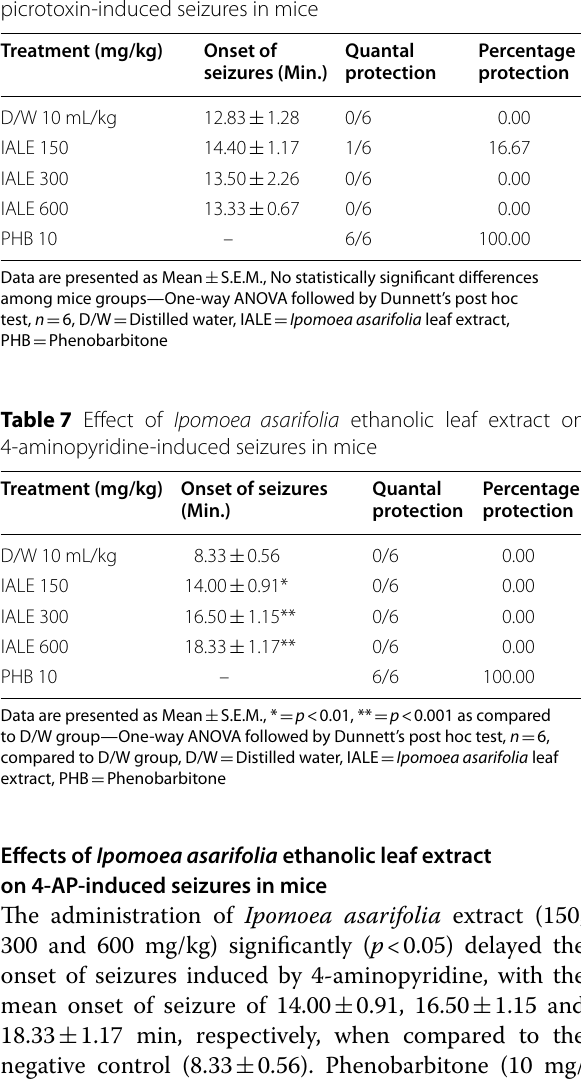
Table 6 Effect of Ipomoea asarifolia ethanolic leaf extract on picrotoxin-induced seizures in mice